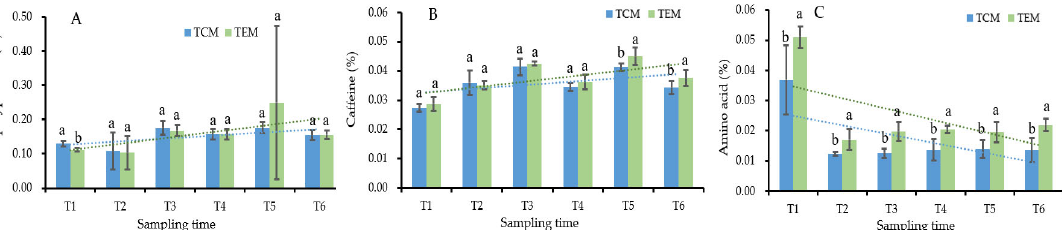
Figure 5. The effects of management mode on the tea quality indices. The different letters labeled in columns are significantly different according to Duncan’s test ( p < 0.05). ( A ) Tea polyphenols, ( B ) caffeine, and ( C ) amino acids. TCM = tea conventional management; TEM = tea ecological management. T1 = spring 2016; T2 = autumn 2016; T3 = spring 2017; T4 = autumn 2017; T5 = spring 2018; T6 = autumn 2018.